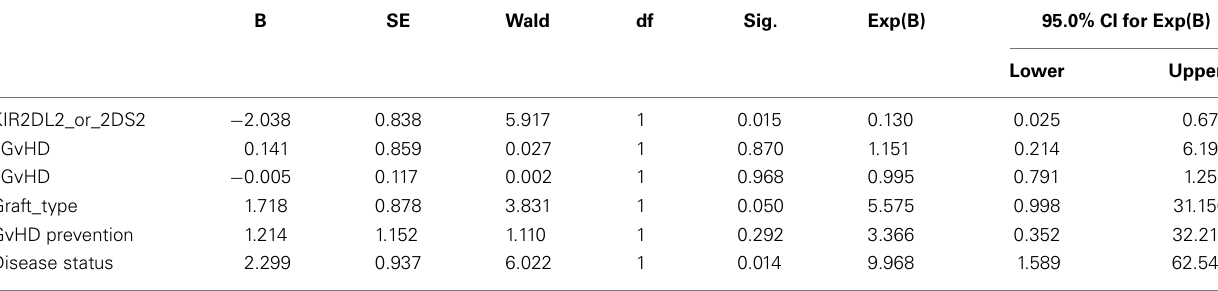
Table 2 | Multivariate Cox regression analyses of relapse rate inAML patients